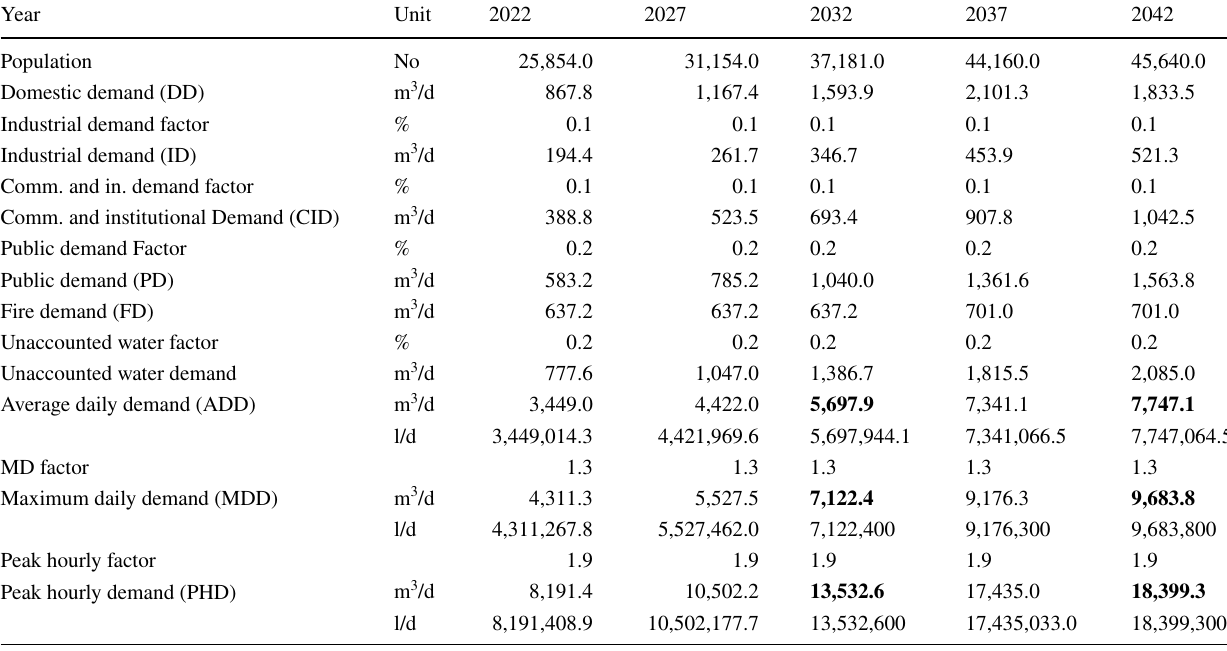
Table 7 Summarized water demand assessments of the study area